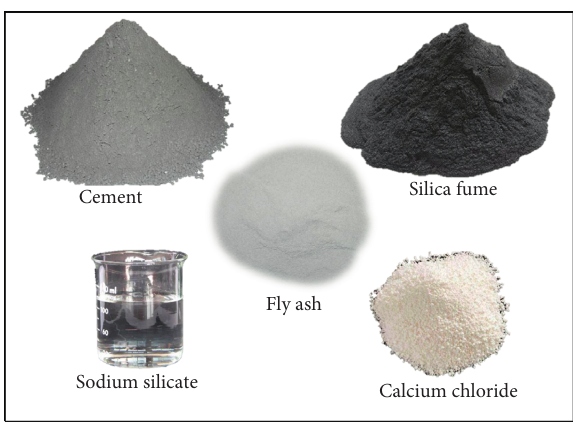
Figure 1: The raw material for grouting